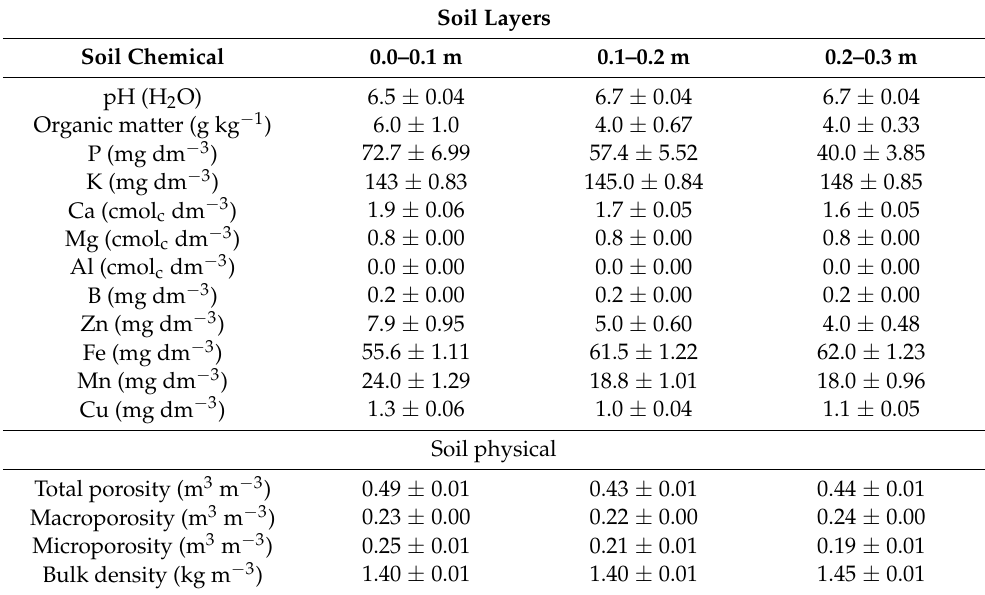
Table 1. Soil characterizations (soil chemistry and physics) in the experimental area in different soil layers (0.0–0.1; 0.1–0.2; 0.2–0.3 m).